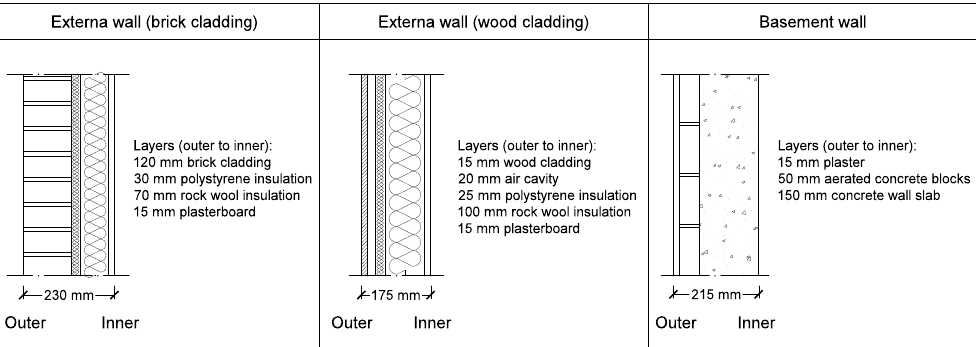
Figure 2. Construction details of the external wall with brick/wood cladding and basement wall.